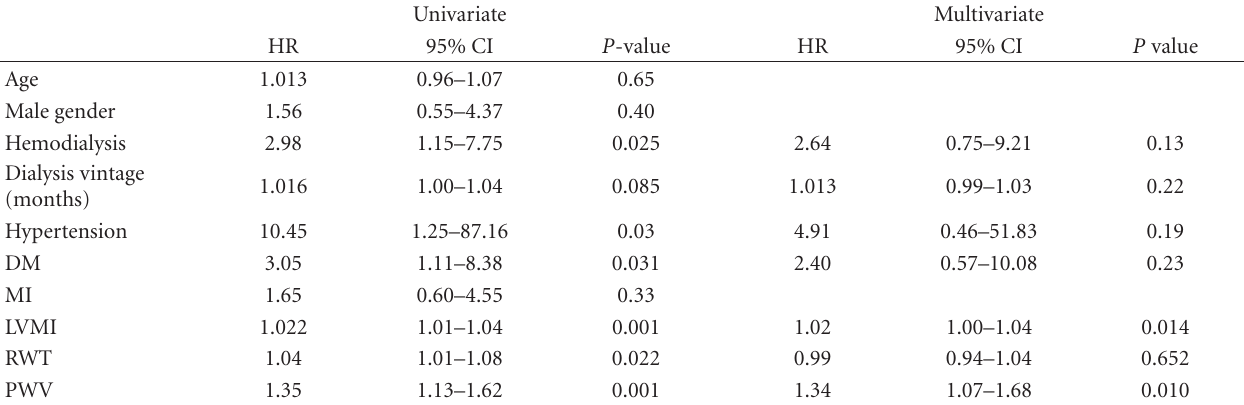
Table 3: Uni- and multivariate logistic regression analysis to predict the presence of LV diastolic dysfunction (defined as E/ SR IVR ≥ 236).